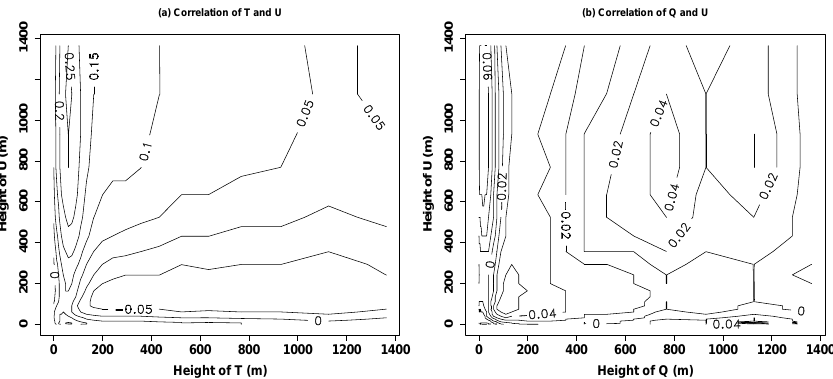
Figure 3. Correlations of zonal wind component U with: ( a ) temperature T, and ( b ) specific humidity Q averaged over the winter period (December 2015–February